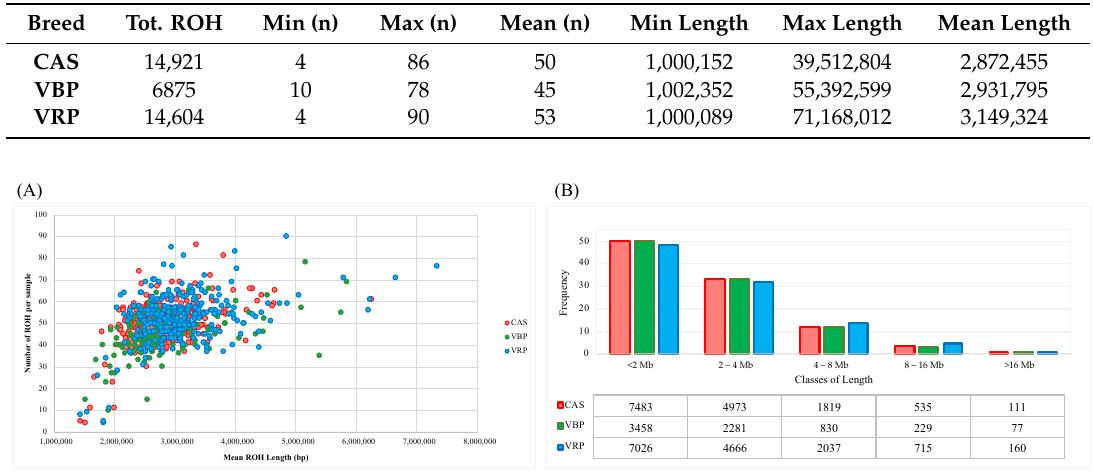
Table 1. Runs of Homozygosity (ROH) descriptive statistics; length expressed in bp.